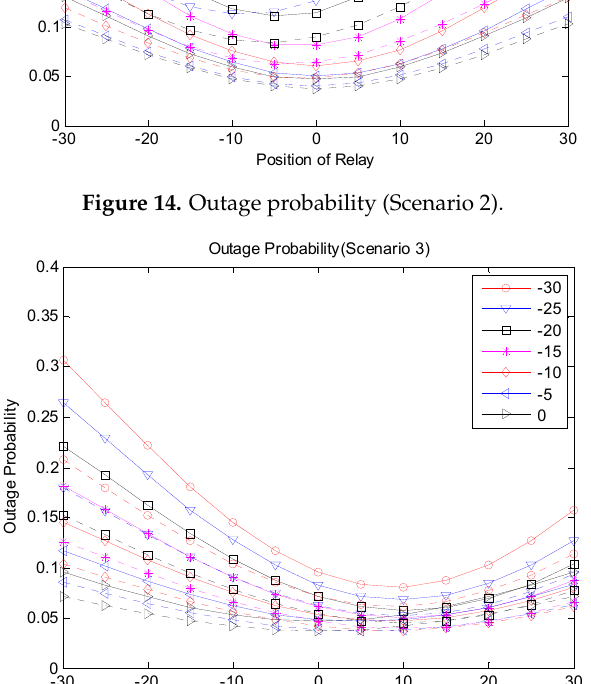
Figure 15. Outage probability (Scenario 3).